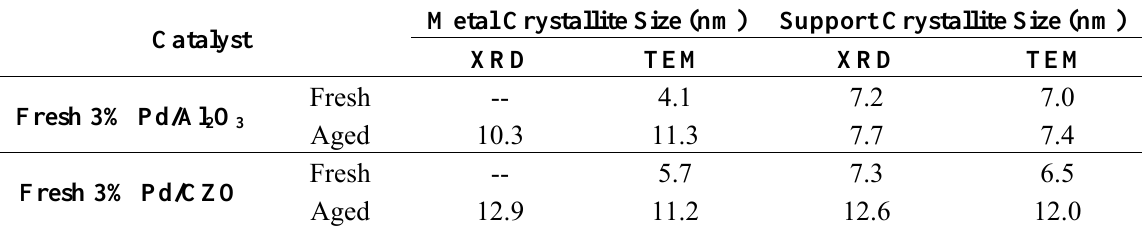
Table 2. Support mean crystallite sizes of the fresh and aged (1050 °C in air for 5 min) 3% Pd/Al 2 O 3 and 3% Pd/CZO measured by TEM and XRD.